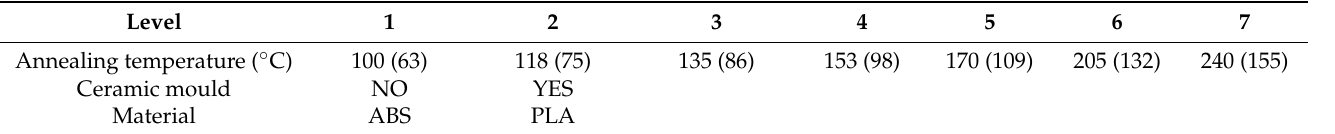
Table 2. Variables and levels.